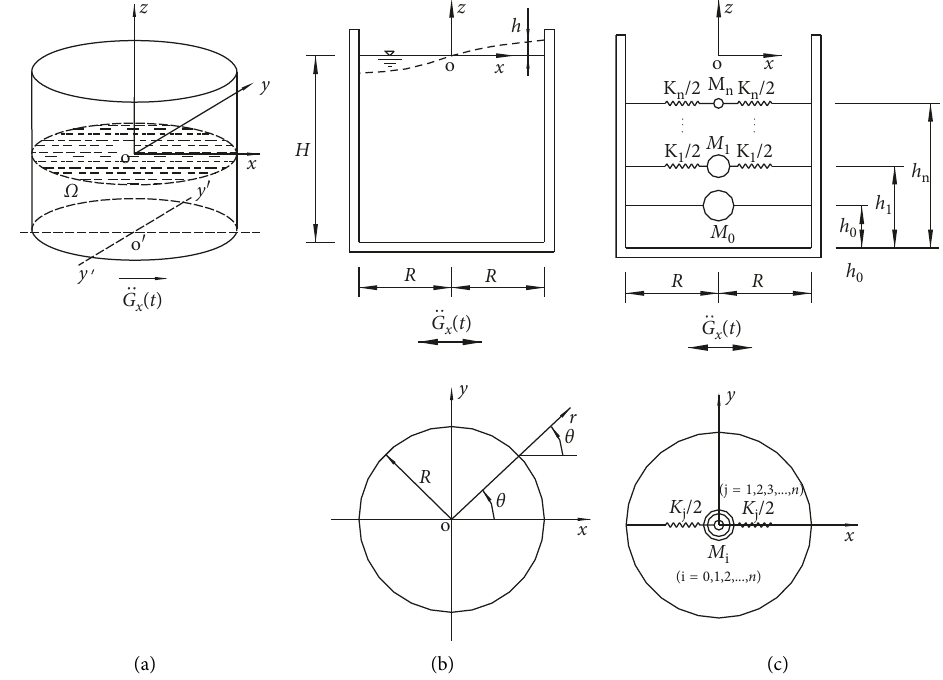
Figure 13: Fluid system and equivalent model of an upright cylindrical tank. (a) A cylindrical tank; (b) fluid system; (c) equivalent